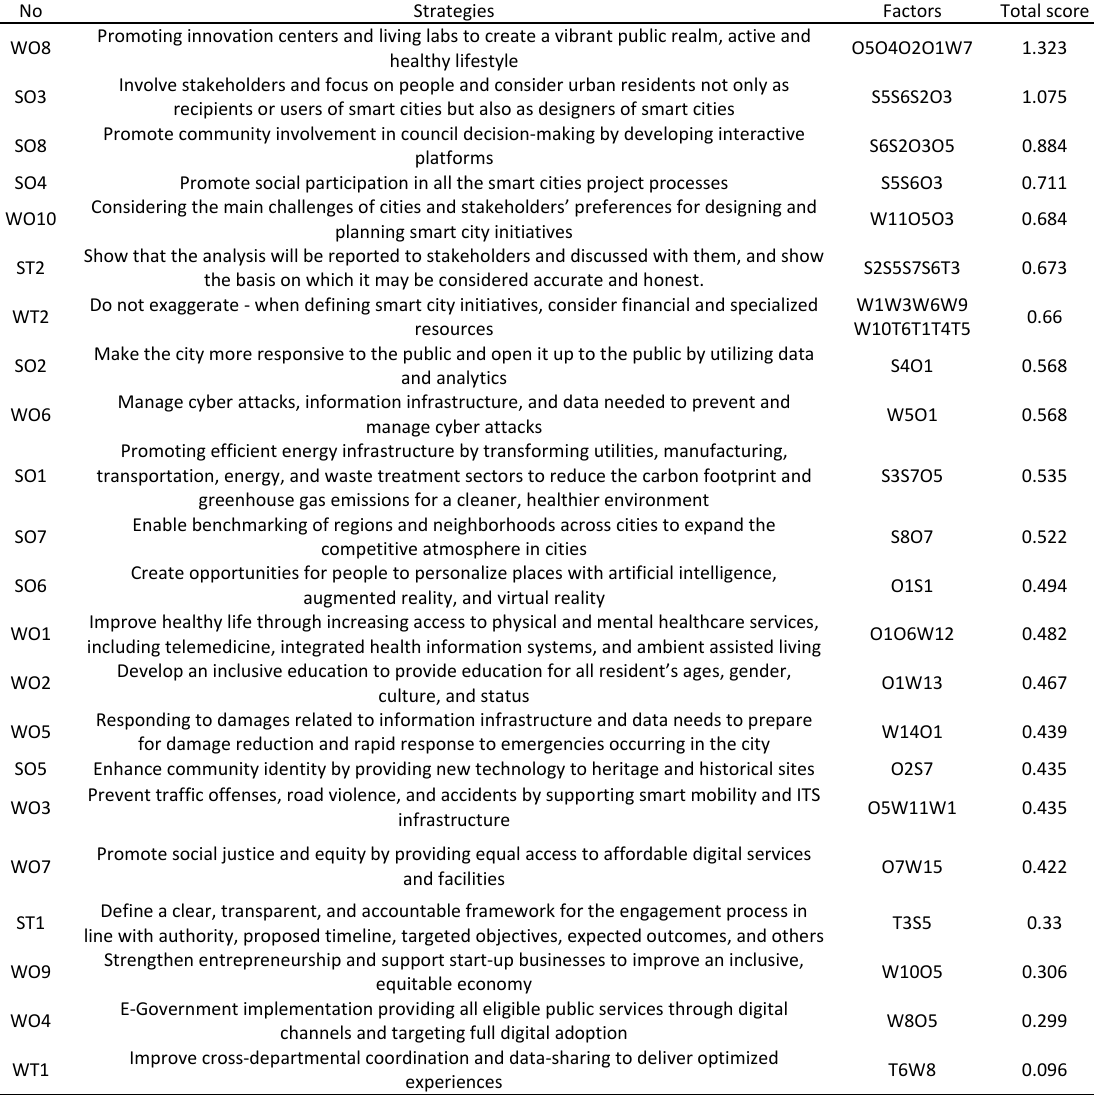
Table 7: The Strategies prioritization by QSPM matrix for smart city developments in Tehran